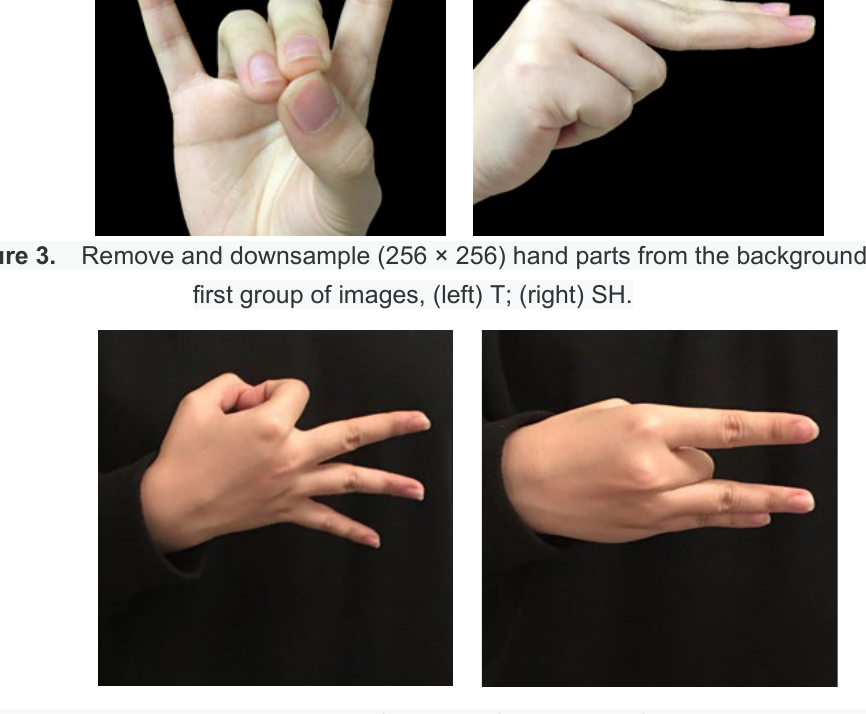
Figure 4. Remove and downsample (256 × 256) hand parts from the background. The second group of images, (left) E; (right)